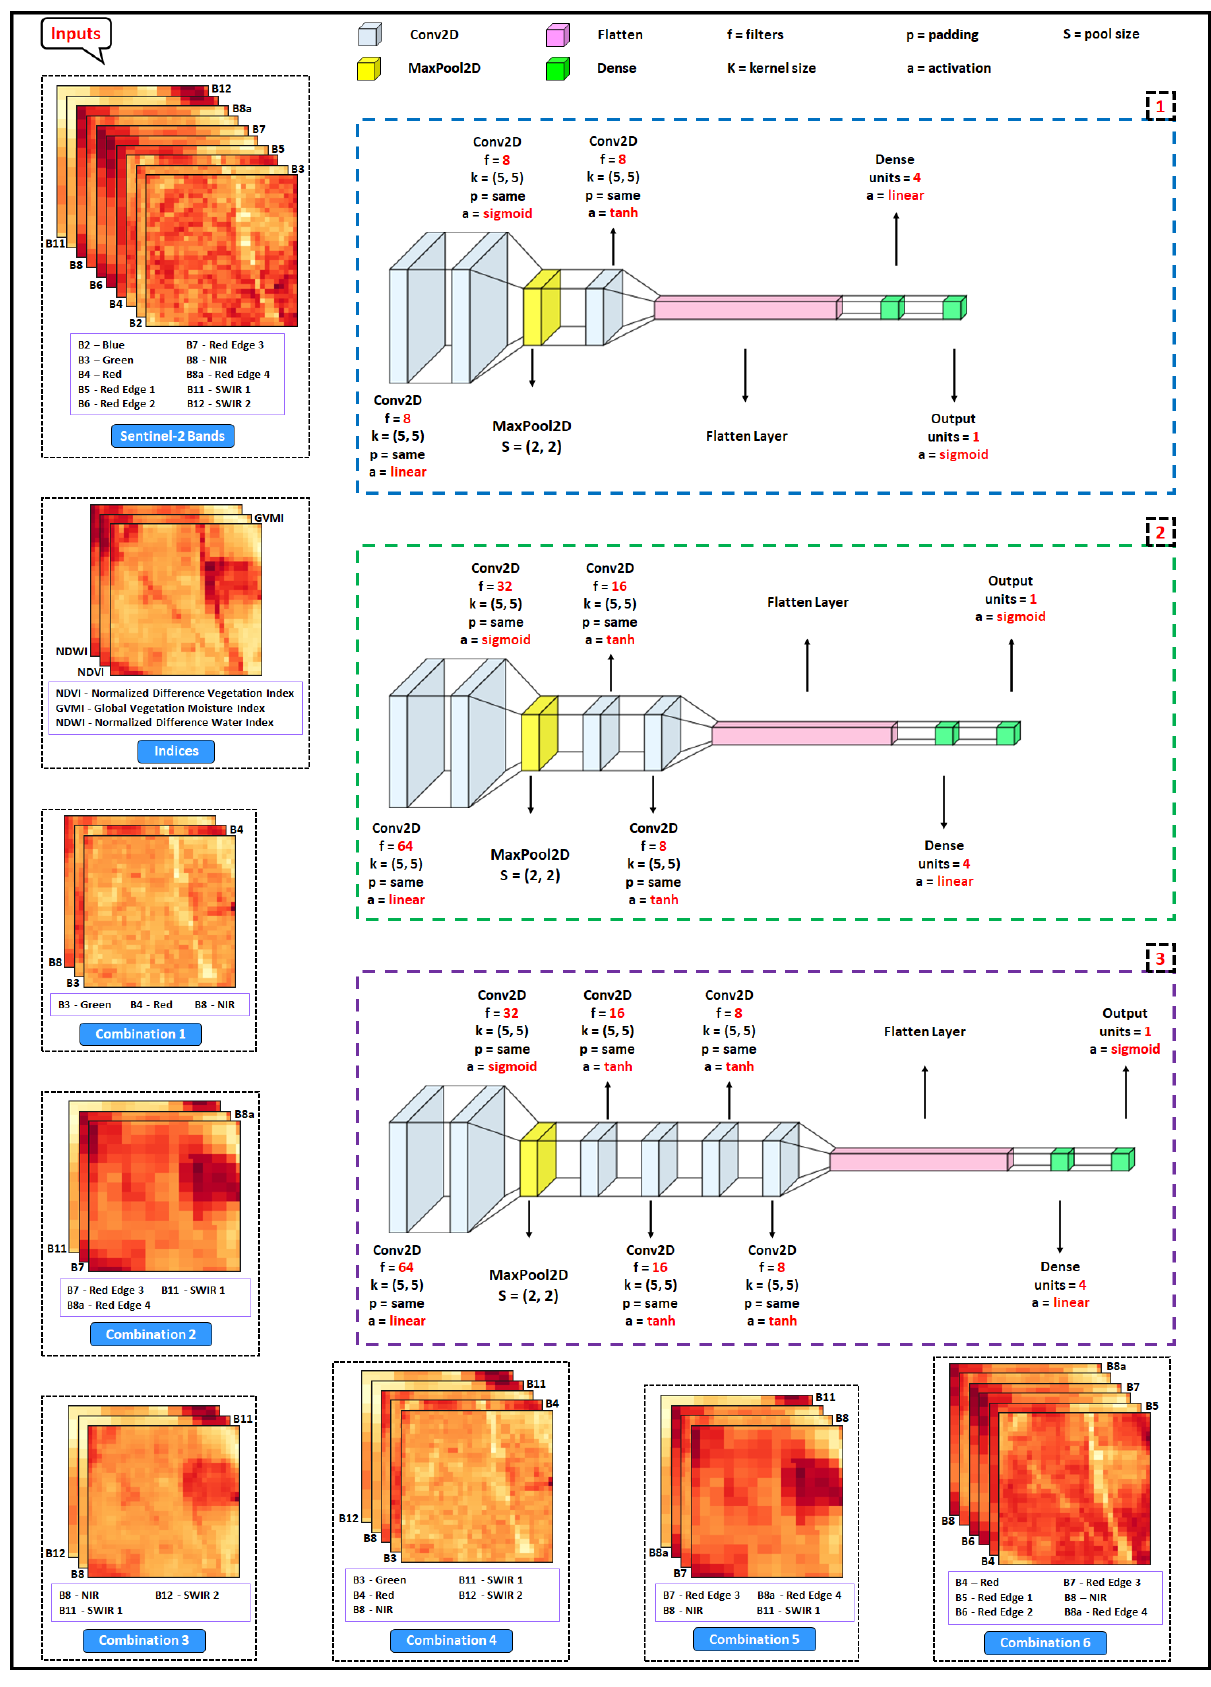
Figure 2. An illustration of Convolutional Neural Network (CNN) architectures.